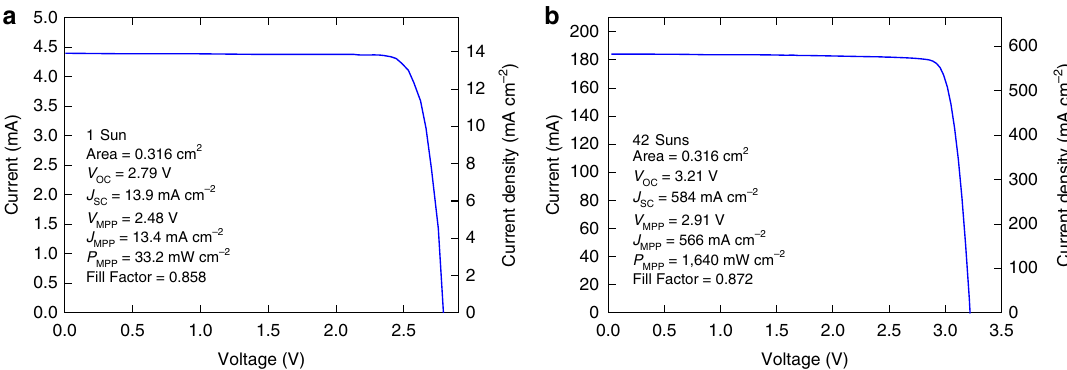
Figure 2 | PV cell performance. The I – V characteristics of the triple-junction solar cell under ( a ) 1sun and ( b ) 42suns, which is the illumination concentration used for the 48h electrolysis. The key performance parameters are included in the figure. I – V curves were collected using both forward and backward voltage sweeps. These measurements generated identical results; thus, this figure shows only the forward sweep results.